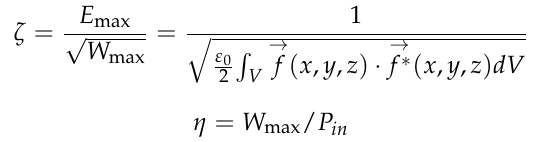
( c ) Figure 8. Single-cavity electric field model of (a) water-pipe-type coaxial resonant (b) standard- disc coaxial resonant (c) donut capacitor-loaded coaxial resonant. 5. Processing and Testing Results A new 2080 MHz capacitively loaded bandpass filter was machined and tested, to verify the design. Figure 9 shows a physical photo of the machined bandpass filter, and Figure 10. Measured response of a new 2080 MHz capacitively loaded cavity-filter, processed. Error! Reference source not found. shows the measurement of the filter-scat- tering parameters, using a vector network analyzer, Agilent E8358A. Figure 9. Physical view of the new 2080 MHz capacitive-load cavity-filter processed.